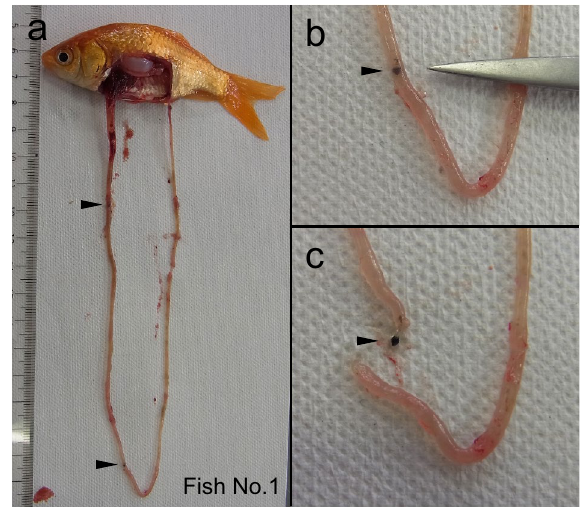
Figure 5. Rubber tips found in the intestine of goldfish (Fish No. 1). Fish were fed a mixture of fish feed and rubber tips. Two pieces of rubber tips were observed in the intestine of the fish at dissection. Arrowheads indicate rubber tips. Photographs ( b ) and ( c ) are closeup of the lower part of photograph ( a ).